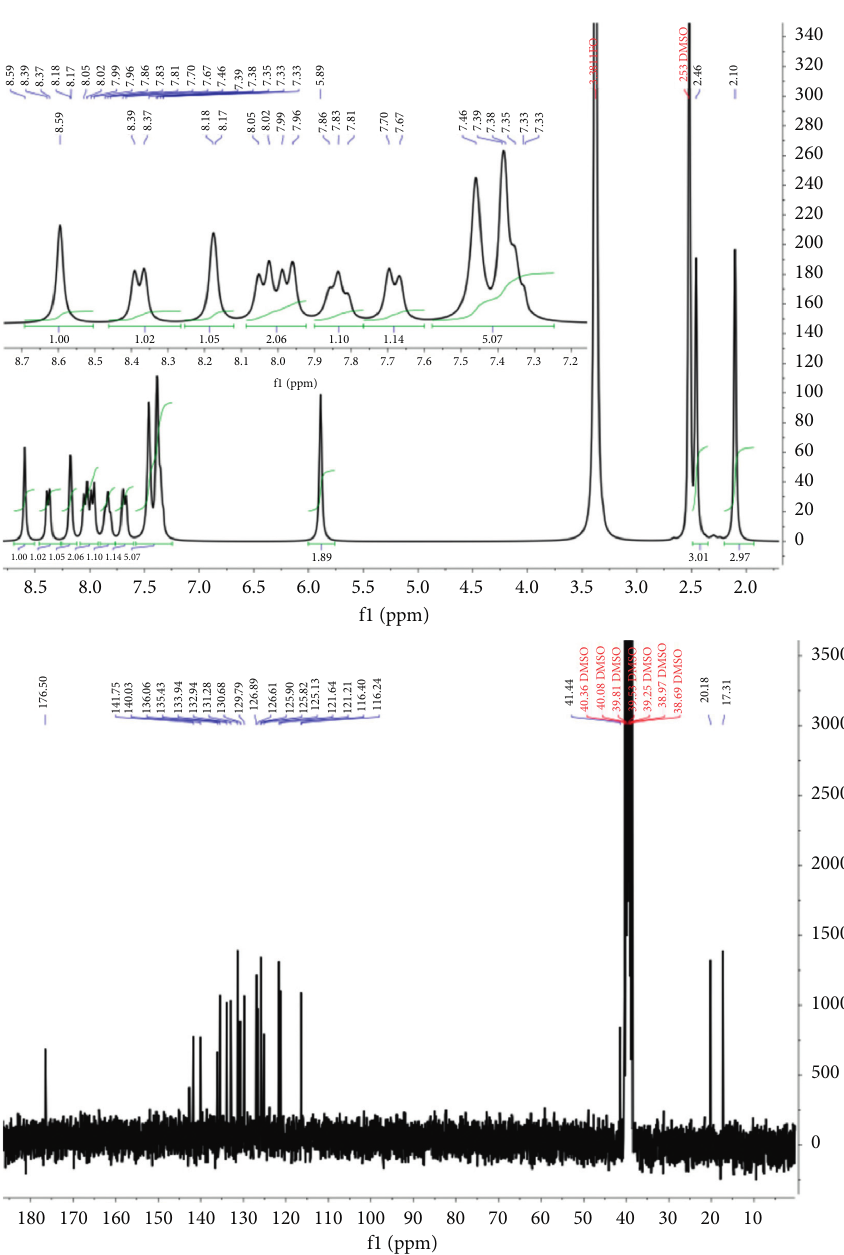
Figure 2: 1 H NMR and 13 C NMR spectra of compound 2e in DMSO-d